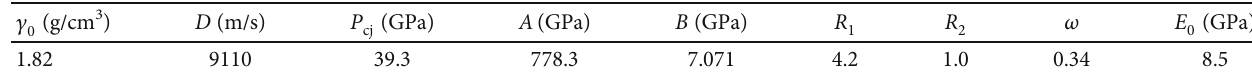
Figure 3: FEA model of the composites separation device. Table 1: Material parameters of the